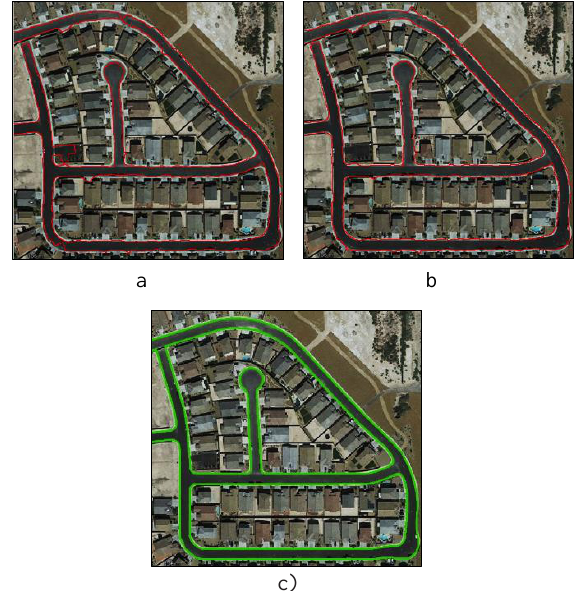
Figure 5. Study a) MSRM result obtained by classification based markers; b) MSRM result produced by interactive markers; c) Ground truth